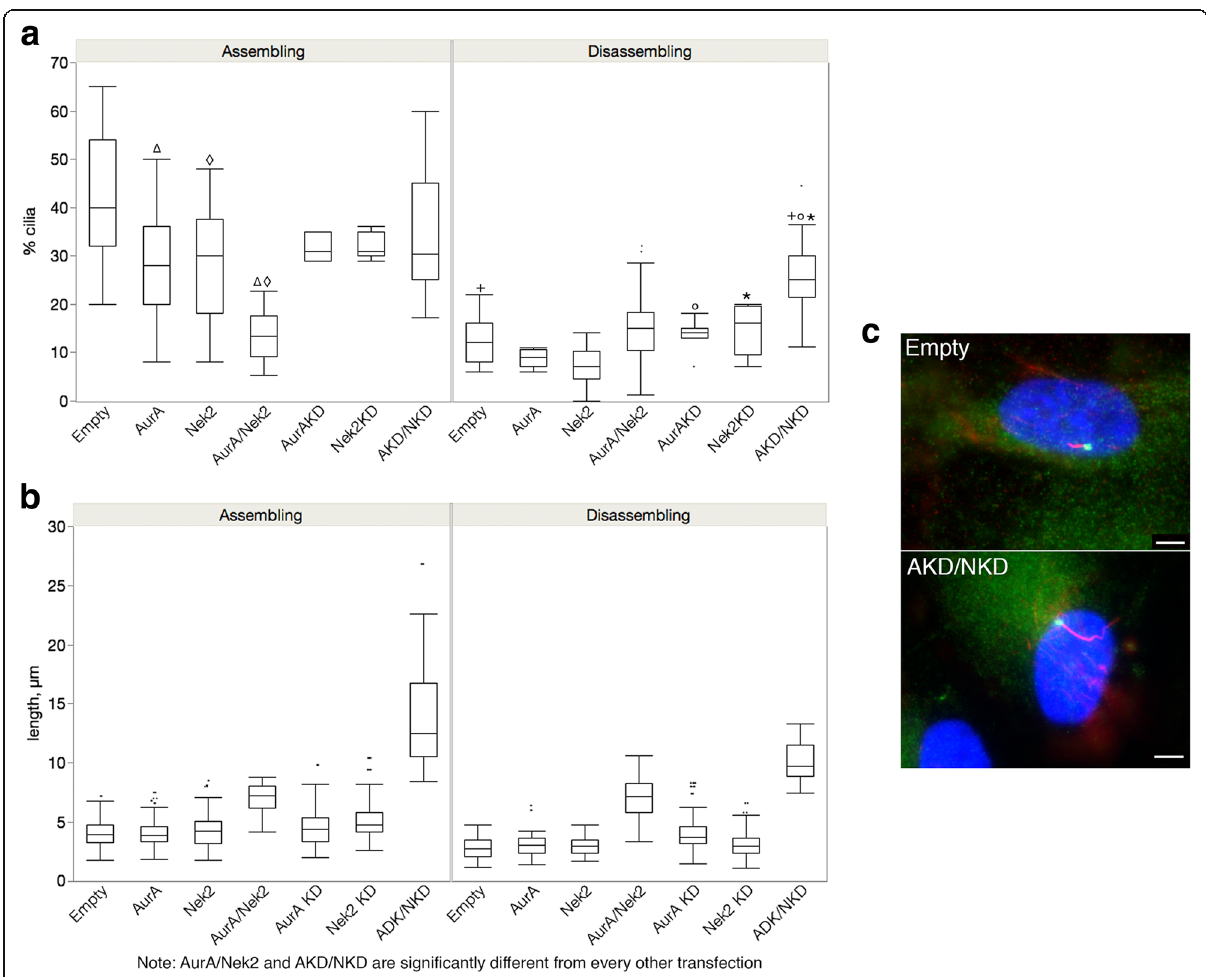
Fig. 2 AurA and Nek2 activity is additive when cilia are growing. ARPE-19 cells were transfected with the following plasmids or combinations: AurA, Nek2, AurA/Nek2, AurAKD, Nek2KD, AurAKD/Nek2KD (AKD/NKD). Transfected cells were grown for 24 h then cilia assembly was induced by serum starvation (assembling, left panels) followed by reintroduction of serum to induce cilia disassembly (disassembling, right panels). Cilia number ( a ) and length ( b ) were measured for a total of 300 cells. Significant differences are indicated with similar symbols; p ≤ 0.05. AurA/Nek2 and AKD/NKD are significantly different from all other transfectants. ( c ) Cells transfected with either empty vector (top) or the AKD/NKD combination (bottom) were stained for gamma tubulin in green, acetylated tubulin in red, and DNA in blue. Scale bar equals 10 μ m. The means for cilia number and length ±